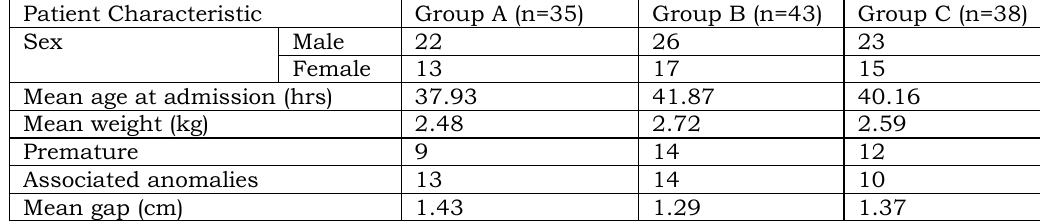
Table 1 Comparison of patient characteristics in the three groups